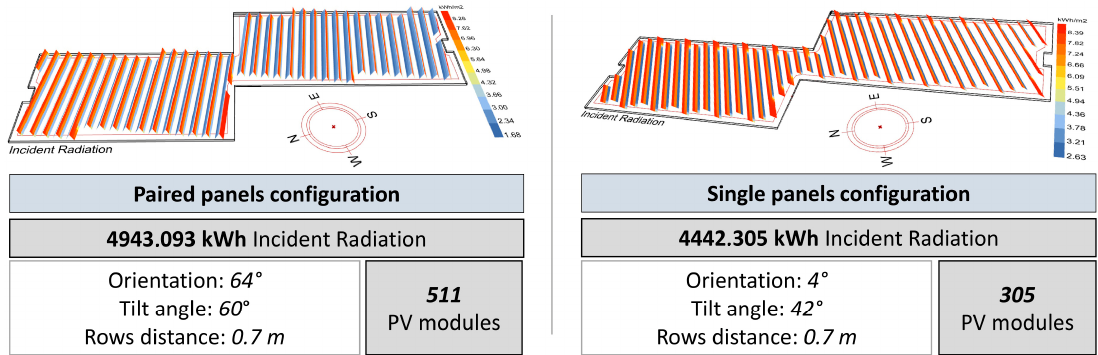
Figure 7. Comparison between the two different configurations of PV panels installed on the roof to find the optimal solution for modules to maximize the electrical energy production.